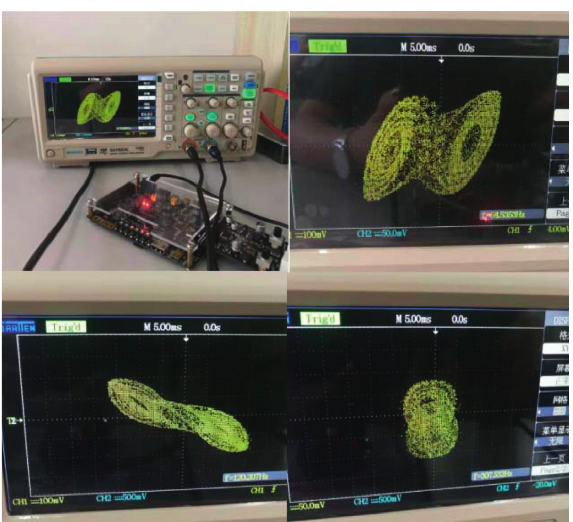
Figure 19: Implementation platform and exemplification of the double-scroll chaotic attractors generated by the FPGA implementation of the multistable modified fourth-order Chua’s chaotic system.